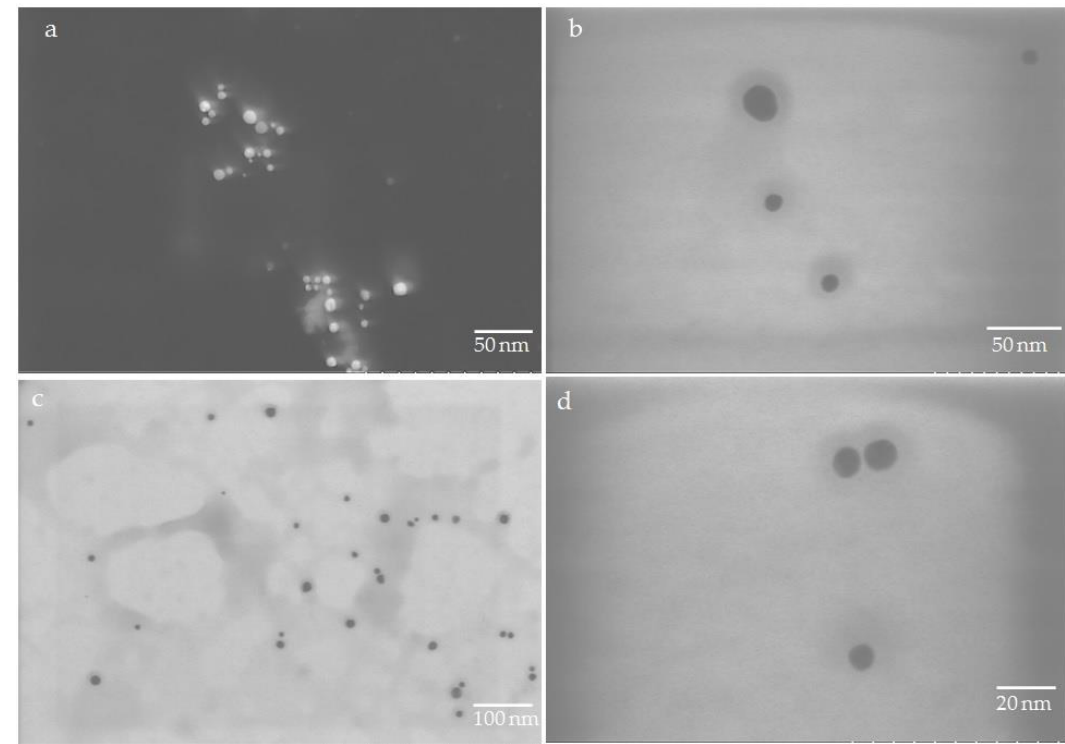
Figure 7. SEM ( a ) and TEM ( b – d ) micrographs of spherical shaped Ag-SiO 2 nanohybrid synthesized by G. mutabilis.